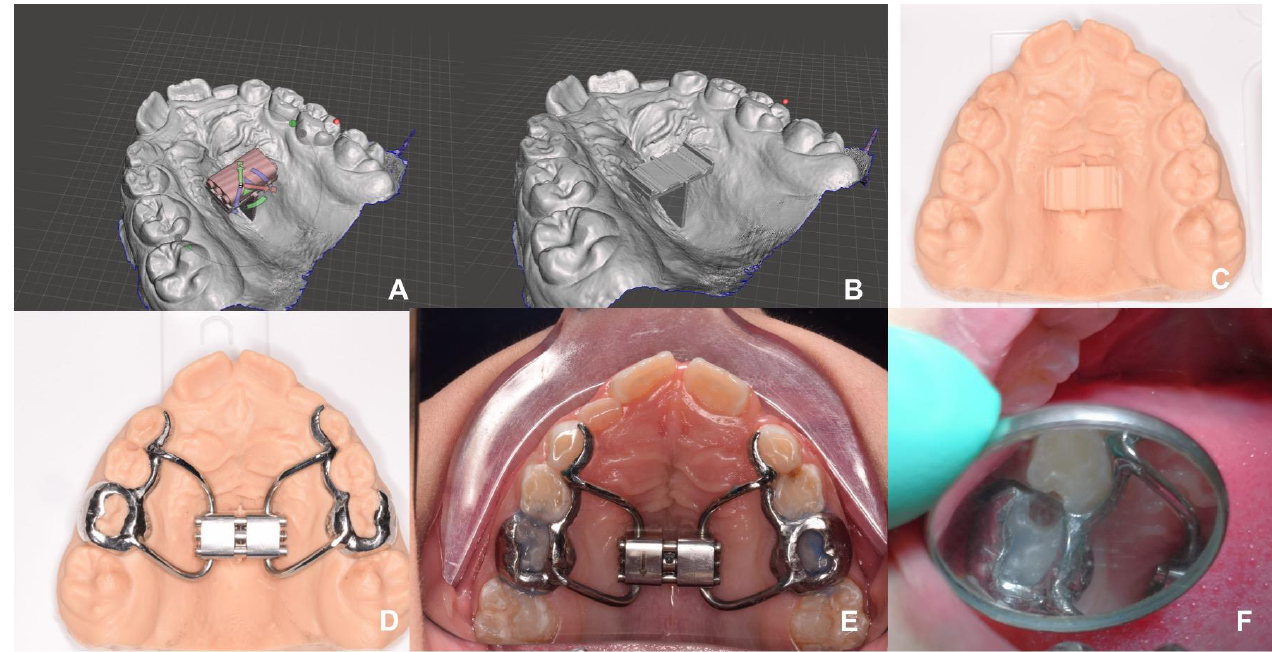
Figure 21. CAD-CAM maxillary expander. ( A ), Positioning of the template matched with digital screw; ( B ), template in place according anatomical and biomechanical characteristics, ( C ), 3D printed maxillary model with screw template; ( D ), maxillary expander with laser-melted frame- work and screw placed onto the template; ( E ), intra-oral view; ( F ), the band of the upper-left decid- uous second molar was designed with an open shape to allow for temporary